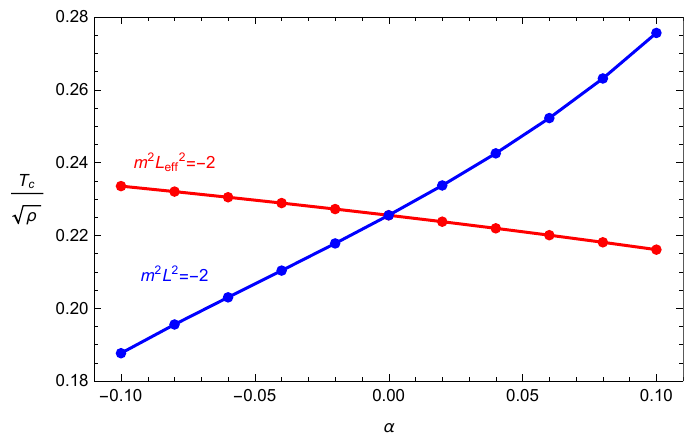
Figure 4 . The critical temperature T c of the scalar operator O − as a function of the Gauss-Bonnet parameter for the fixed masses of the scalar field m 2 L 2 = − 2 (blue) and m 2 L 2